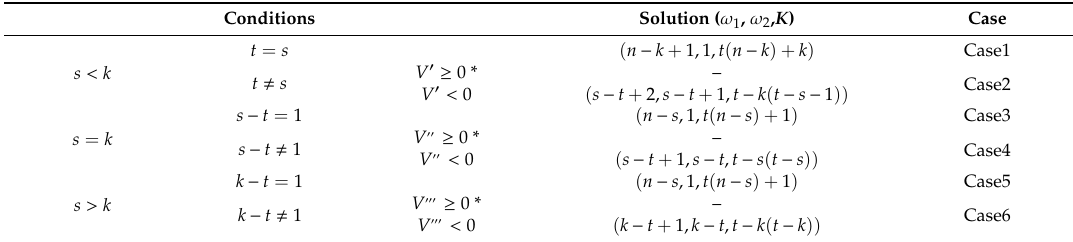
Table 7. The solutions of IPM for all